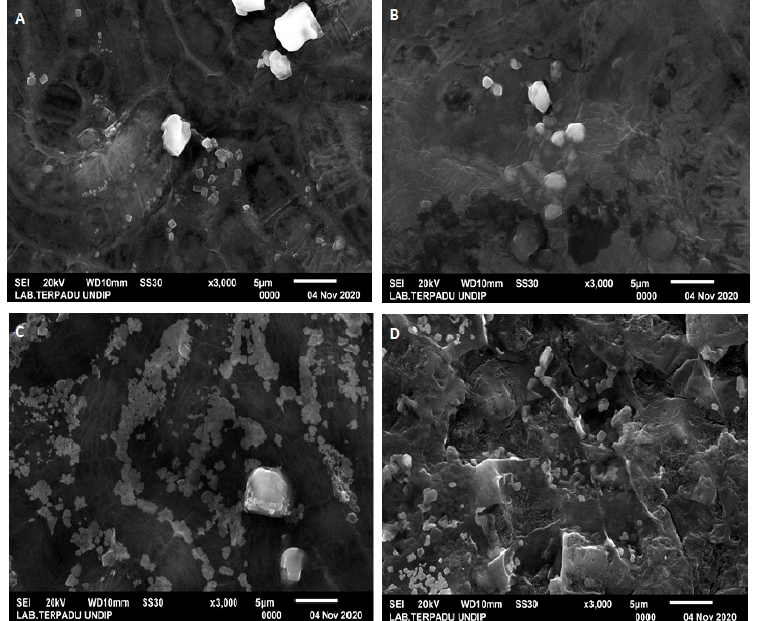
Figure 5. SEM analysis results of brackish water culture S. platensis for 30 days. ( A ) S. platensis without Styrofoam treatment. ( B ) S. platensis treated with Styrofoam 150 mg/500 mL. ( C ) S. platensis treated with Styrofoam 250 mg/500 mL. ( D ) S. platensis treated with Styrofoam 400 mg/500 mL.